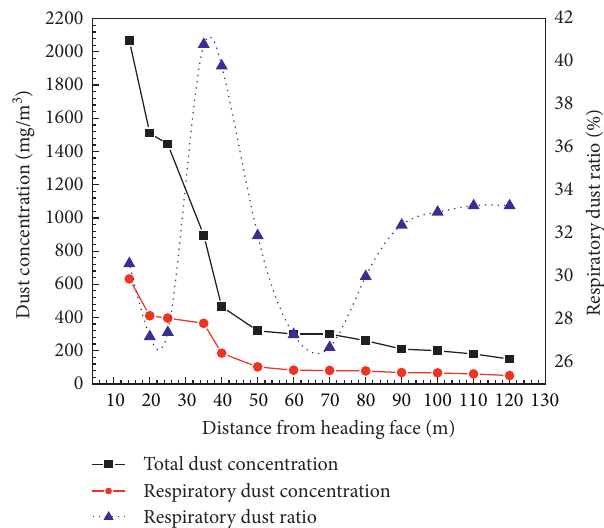
Figure 10: Distribution of dust concentration along the